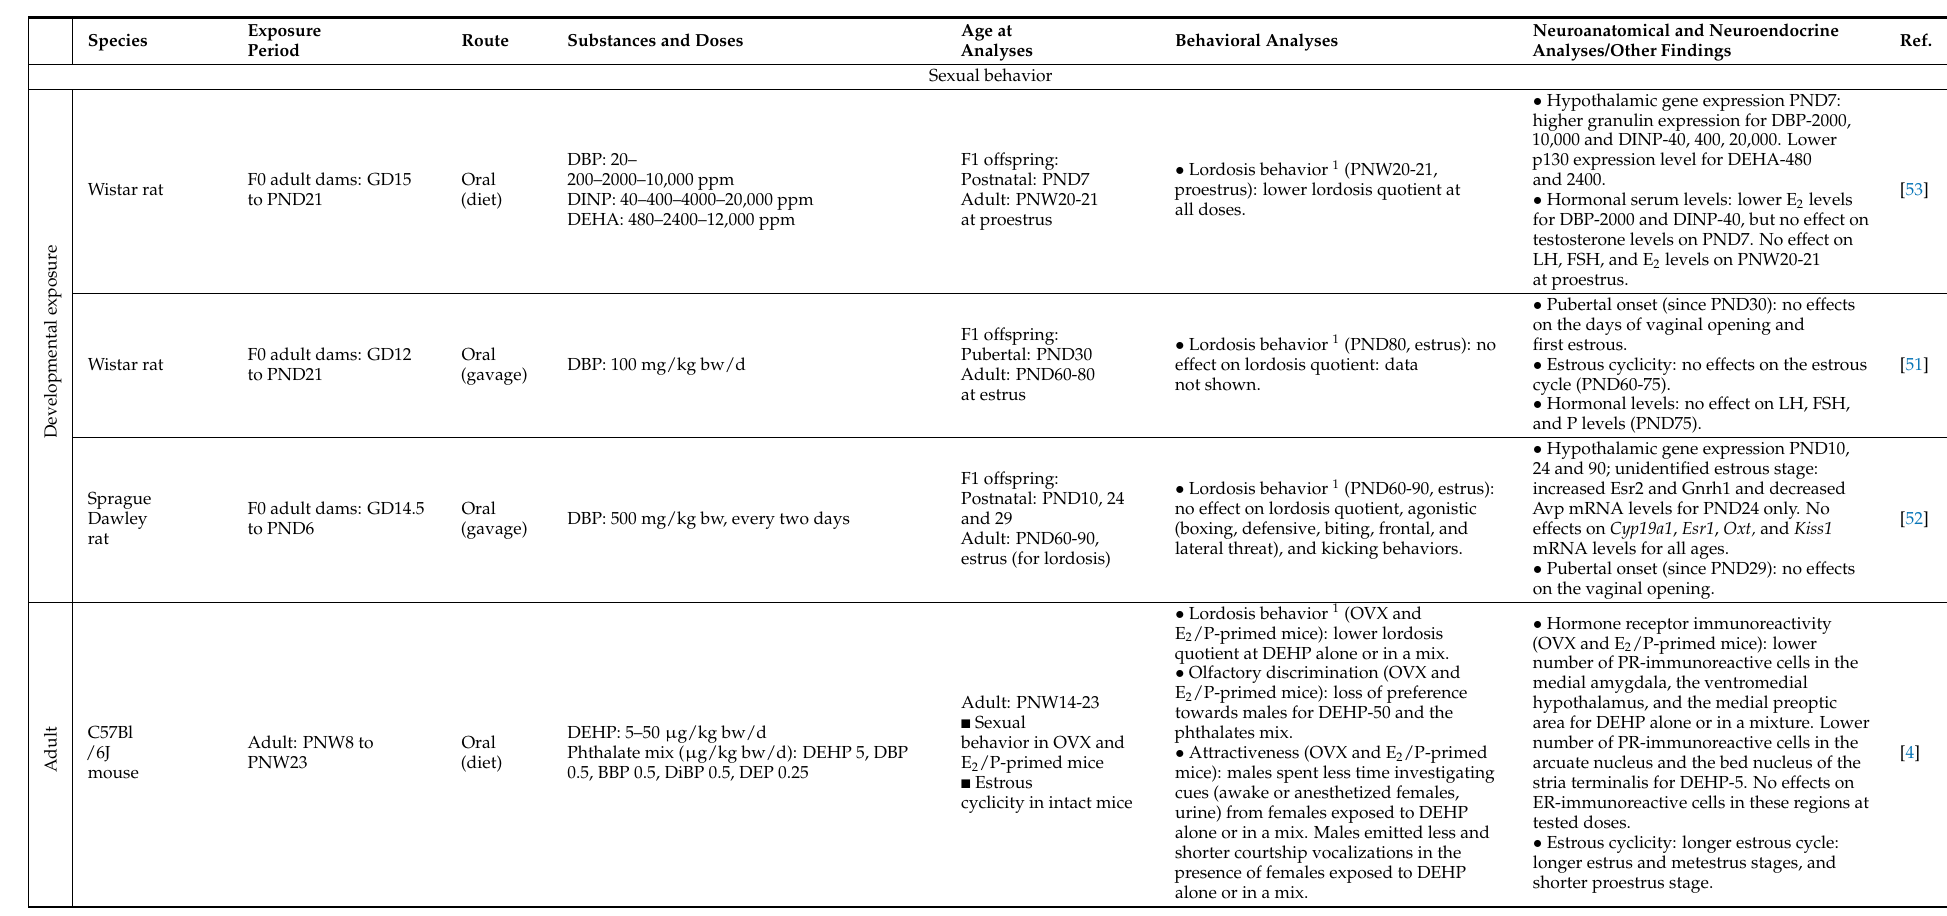
Table 1. Effects of phthalate exposure on female reproductive behaviors. Avp, arginine-vasopressin; BBP, benzyl butyl phthalate; Cyp19a1, cytochrome P450 family 19 subfamily member 1; DBP, dibutyl phthalate; DEHA, di-(2-ethylhexyl) adipate; DEHP, Di-(2-ethylexyl) phthalate; DEP, diethyl phthalate; DiBP, diisobutyl phthalate; DINP, diisononyl phthalate; E 2 , estradiol; Esr1 and 2, estrogen receptor 1 and 2; FSH, follicle stimulating hormone; GD, gestational day; GnRH1, Gonadotropin Releasing Hormone 1; Kiss1, kisspeptine 1; LH, luteinizing hormone; Oxt, oxytocin; OVX, ovariectomy; P, progesterone; PND, postnatal day; PNW, postnatal week; PPD, postpartum day; ppm, parts per million. Species Exposure Period Route Substances and Doses Age at Analyses Behavioral Analyses Neuroanatomical and Neuroendocrine Analyses/Other Findings Ref. Sexual